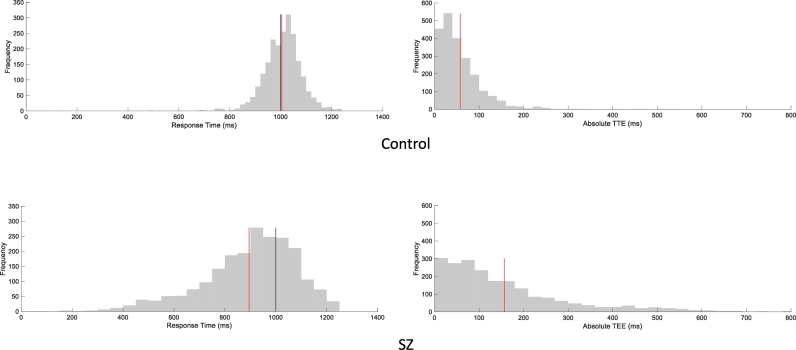
Distributions of RTgo and absolute TEEs. RTgo distributions are left skewed (skewness_SZ = − 0.87, skewness_control = − 2.74) Collision time (black vertical lines), mean values (red vertical lines).